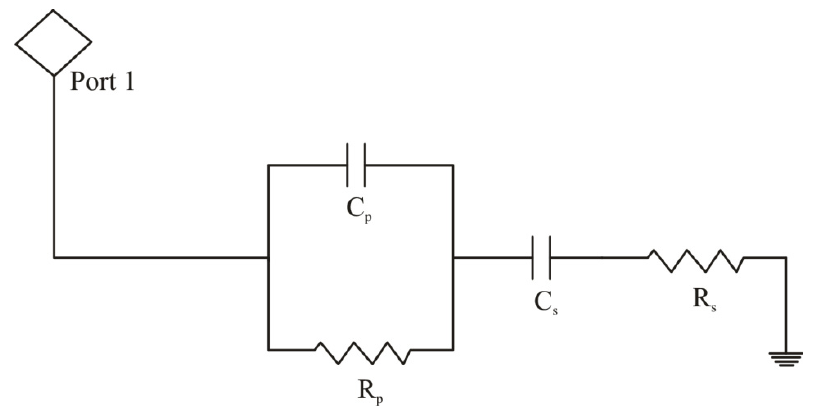
Figure 2. Equivalent circuit diagram of interdigital electrodes, covered with sensitive